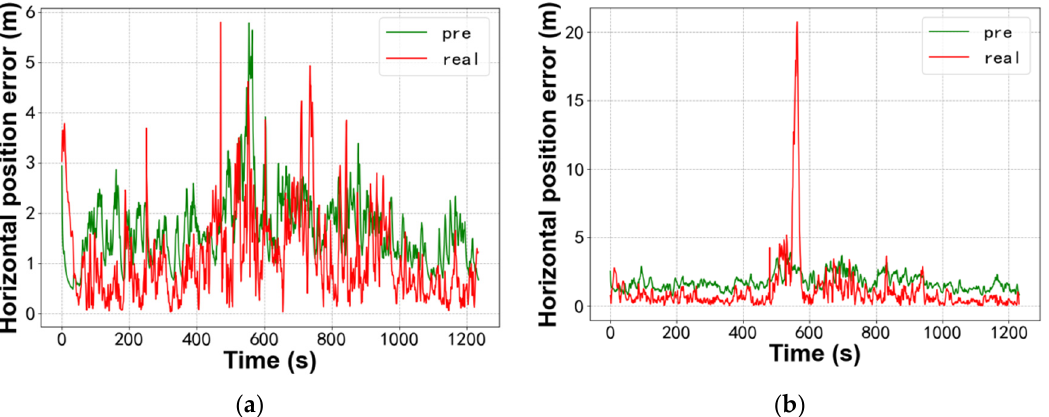
Figure 4. Comparison of horizontal errors. ( a ) Smartphone Huawei P30; ( b ) Smartphone Huawei P40.